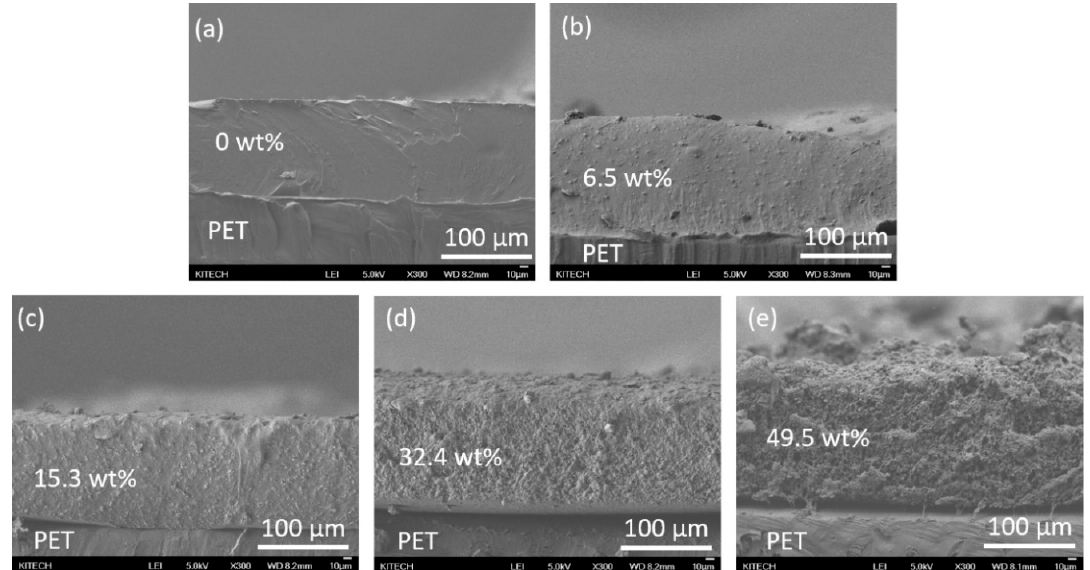
Figure 8. Cross-section SEM images of the UiO-66/DSPD composite films with ( a ) 0, ( b ) 6.5, ( c ) 15.3, ( d ) 32.4, and ( e ) 49.5 wt.% UiO-66 contents on polyethylene (PET) substrates.